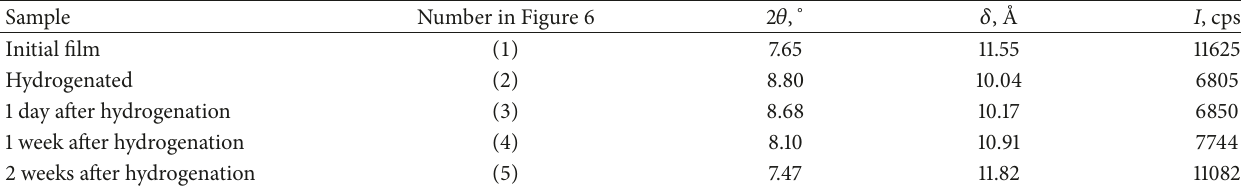
Table 2: Interlayer spacing ( 𝛿 ) calculated from the XRD data for the as-prepared, hydrogenated, and aged V 2 O 5 xerogel films.